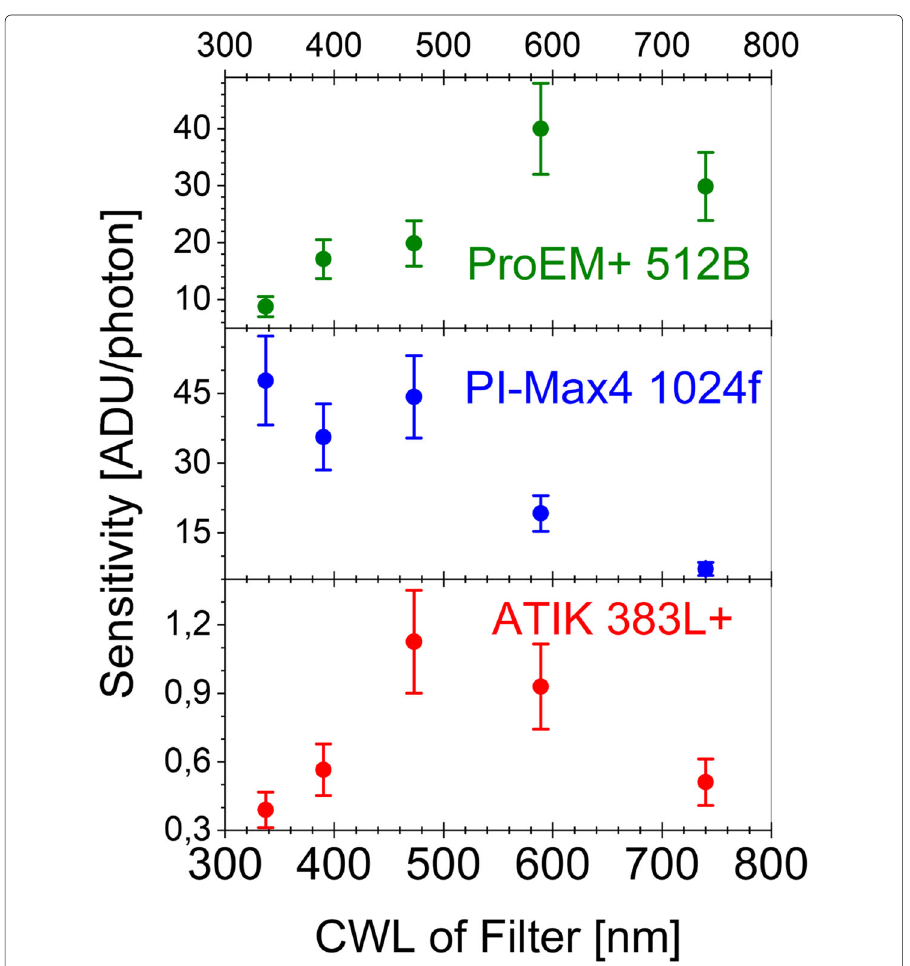
Fig. 7 The sensitivity of the three camera systems which have been tested is shown versus the center wavelength (CWL) of the filters used to determine the wavelength position of the measurement. Due to the S20 cathode of the image intensifier the PI-Max4 has a high sensitivity in the blue and UV wavelength